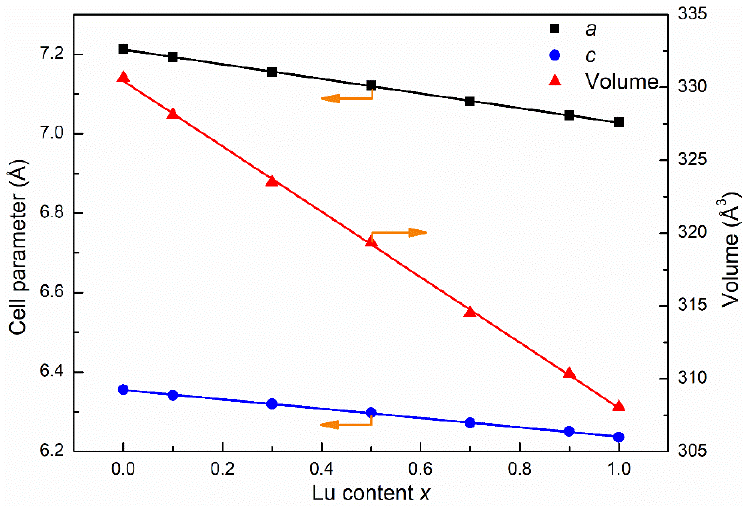
Figure 2. Lattice parameters a , c , and unit cell volume as functions of x values in Lu x Gd 1 − x VO 4 .